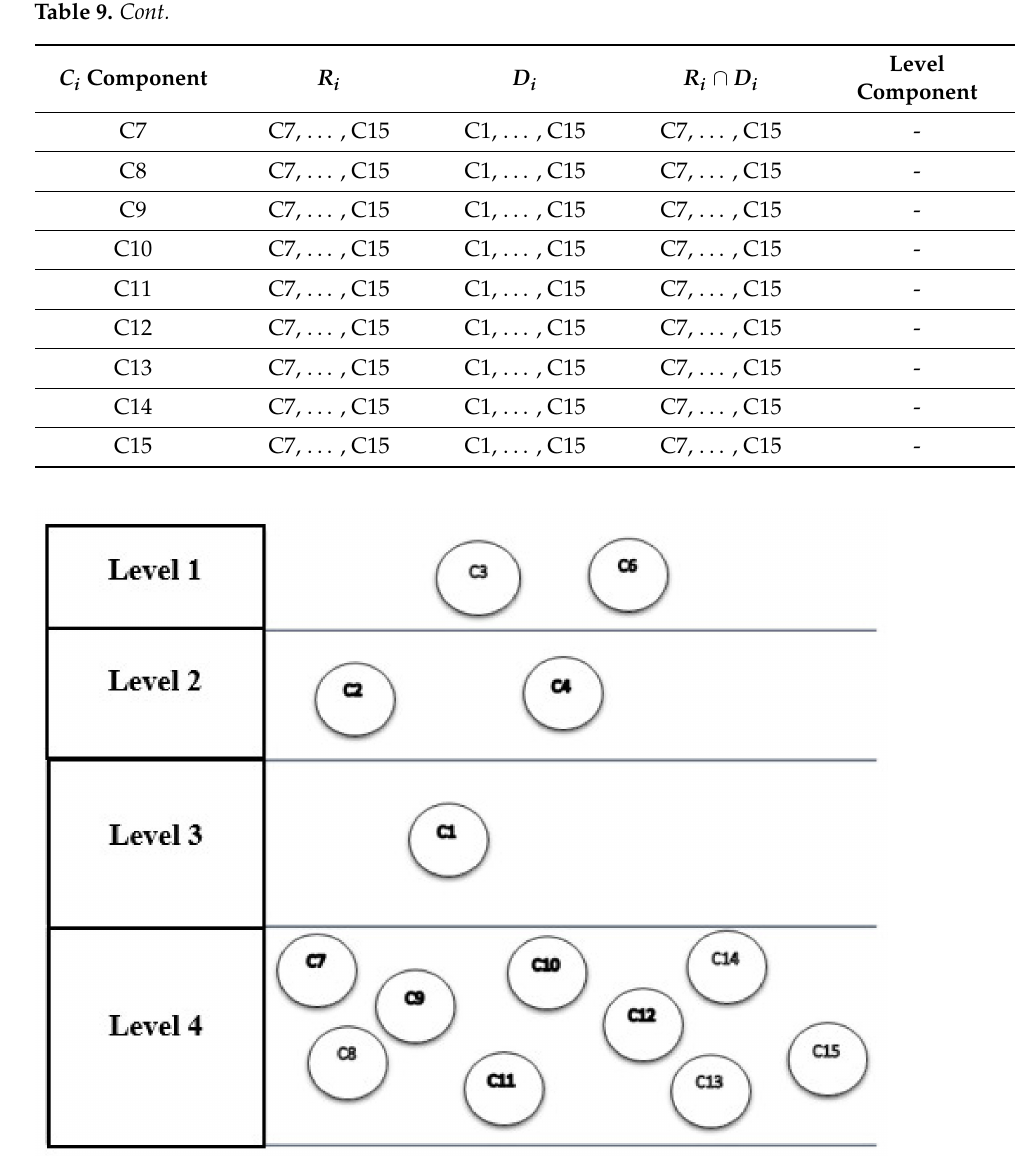
Figure 8. The network structure of the components and their levelling. It is important to take into account that the network structure of the components (out- put of Dematel technique) and their levelling (output of structural interpretive modelling) are all shown in Figures 8 and 9. The levels that appear in the technique of interpretive structural modelling indicate the severity of the effect of the components, respectively. This means that the first level shows the most common effect level and the last level shows the most common cause level (see Figure